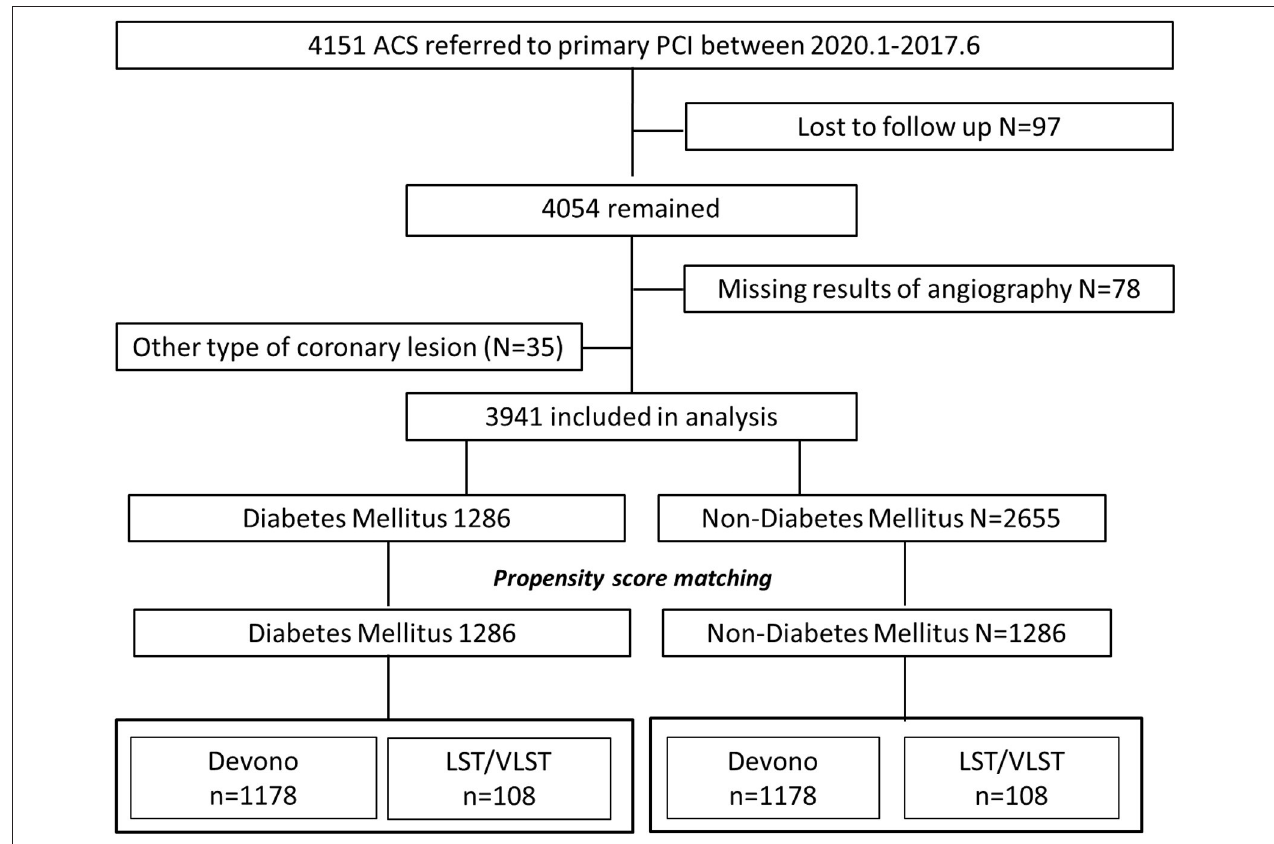
FIGURE 1 | Flow chart. ACS, acute coronary syndrome; LST, late stent thrombosis; VLST, very late stent